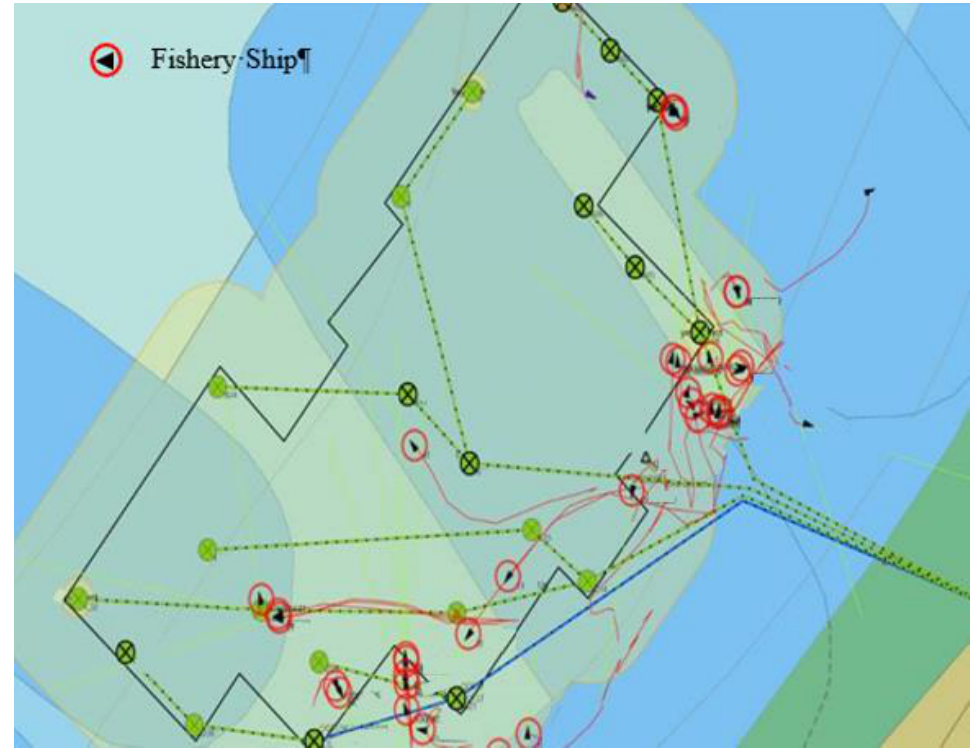
Figure 4. Tracks of fishing vessels in the offshore wind farm in the Central Taiwan Strait close to west coast of Taiwan based on AIS data. Source: based on the information in Reference [30].